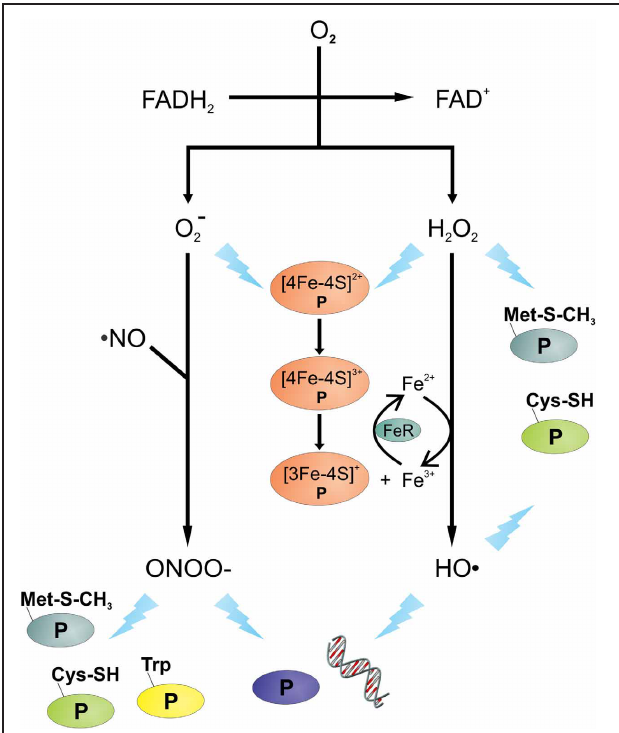
FIGURE 1 | Overview of oxidative and nitrosative stressors and their potential targets. The transfer of electron(s) from the reduced FAD of flavoenzymes to oxygen (O 2 ) can produce superoxide anions (O − 2 ) and/or hydrogen peroxide (H 2 O 2 ). Reaction of O − 2 with nitric oxide ( · NO) can lead to the formation of peroxynitrite (OONO − ). Intracellular ferric (Fe 3 + ) reduction is catalyzed by ferric reductase (FeR), the Fe 2 + can react with H 2 O 2 to generate hydroxyl radicals (HO · ). Damage to DNA and protein(s) is shown as a lightning bolt. Proteins are presented using letter